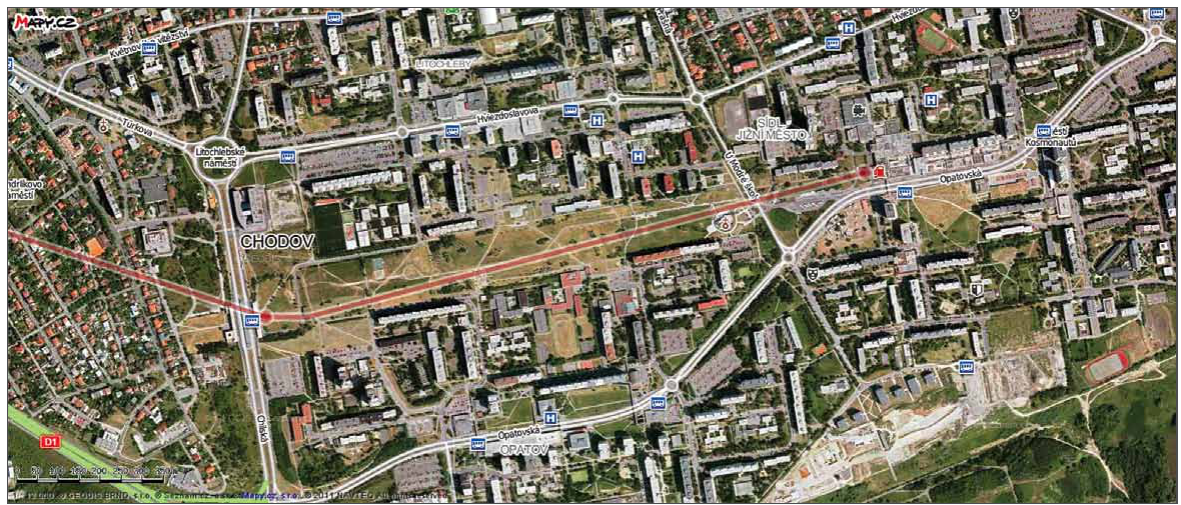
fig. 1. ortophotomap of the